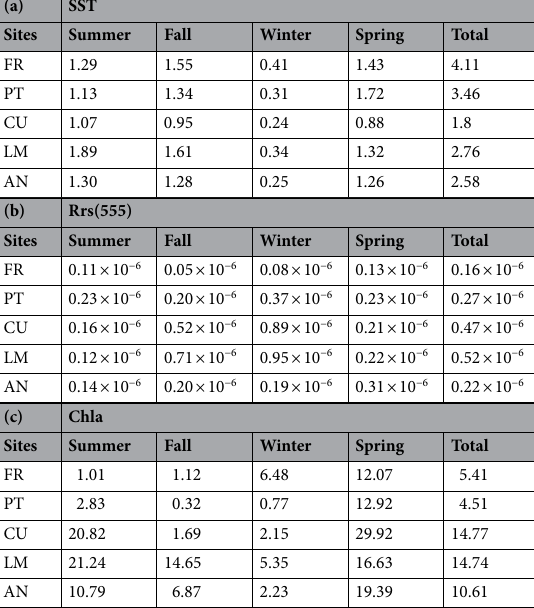
Table 1. Variance of environmental variables for the 18 years of satellite data at the latitudes of sampling (see white dashed lines in Fig.